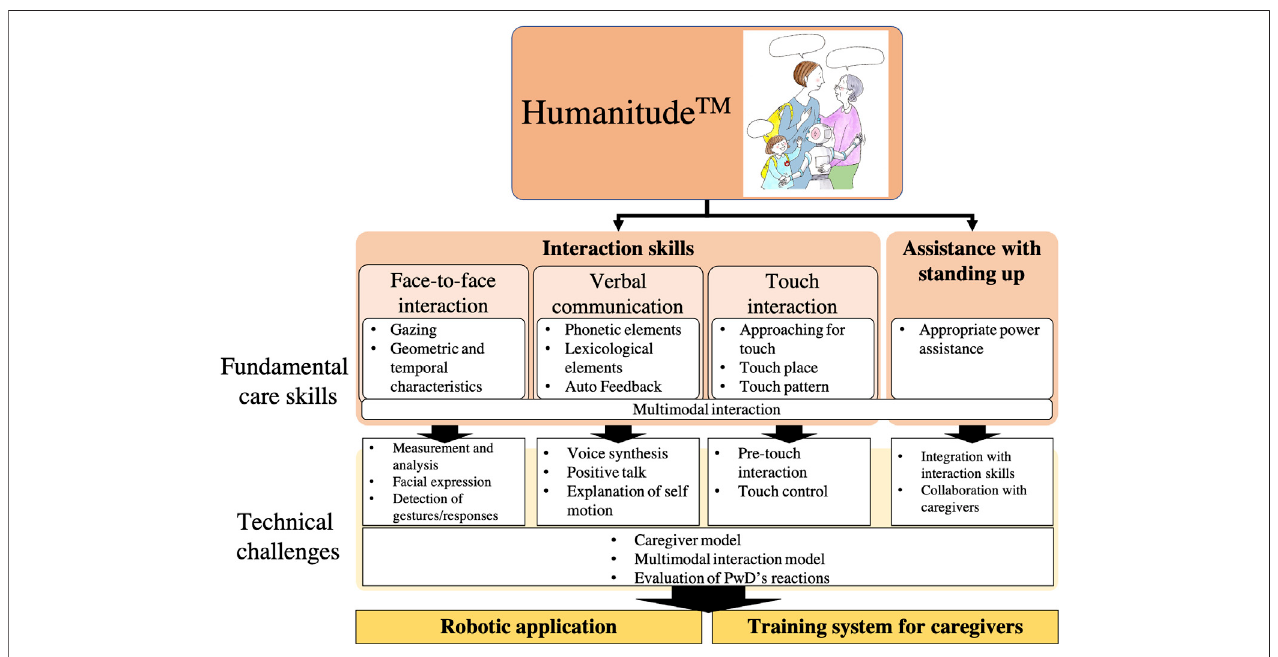
FIGURE 1 | Fundamental skills in Humanitude and technical